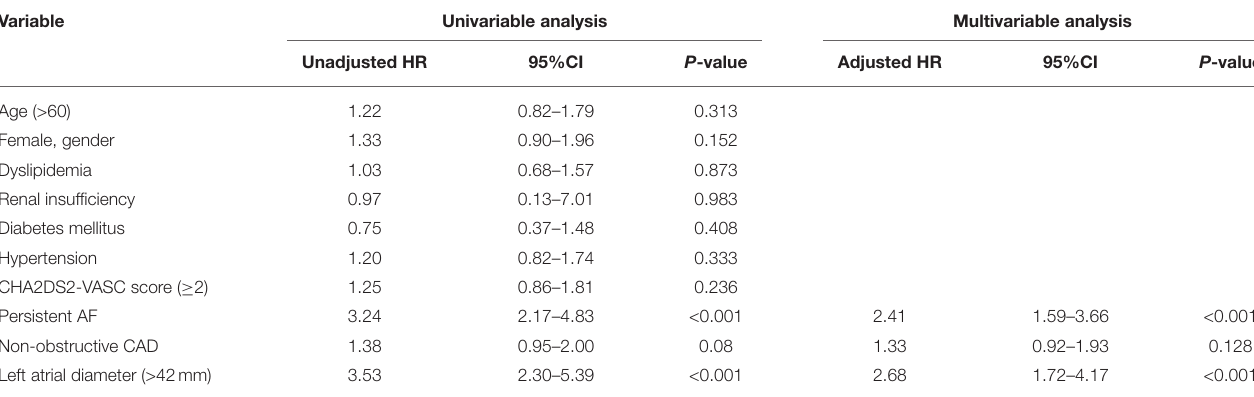
TABLE 4 | Univariable and multivariable regression analyses of the recurrence of atrial fibrillation in the patients without obstructive CAD.